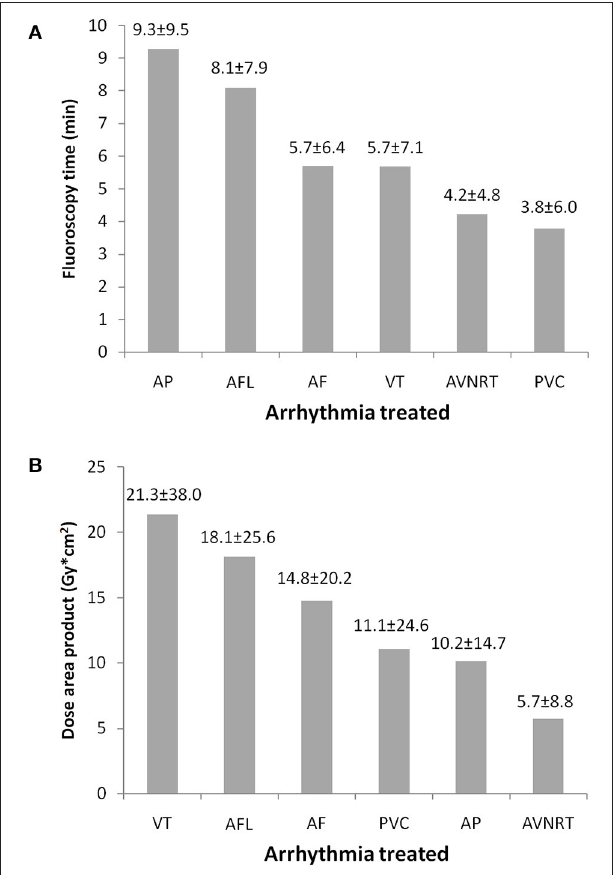
FIGURE 3 | Fluoroscopy time (A) and dose area product (B) by arrhythmias treated in procedures with fluoroscopy use. Fluoroscopy time and dose area product. AF, atrial fibrillation; AFL, atrial flutter; AP, accessory pathways; AVNRT, atrioventricular nodal reentrant tachycardia; PVC, premature ventricular contraction; VT, ventricular